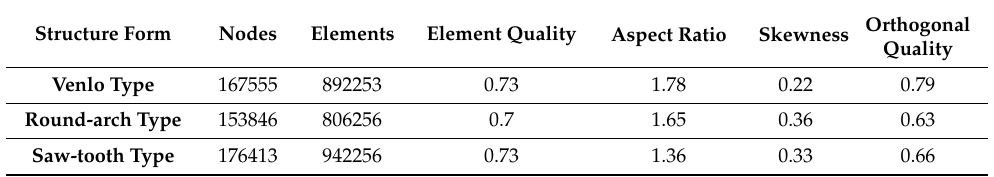
Table 2. Greenhouse grid quality evaluation